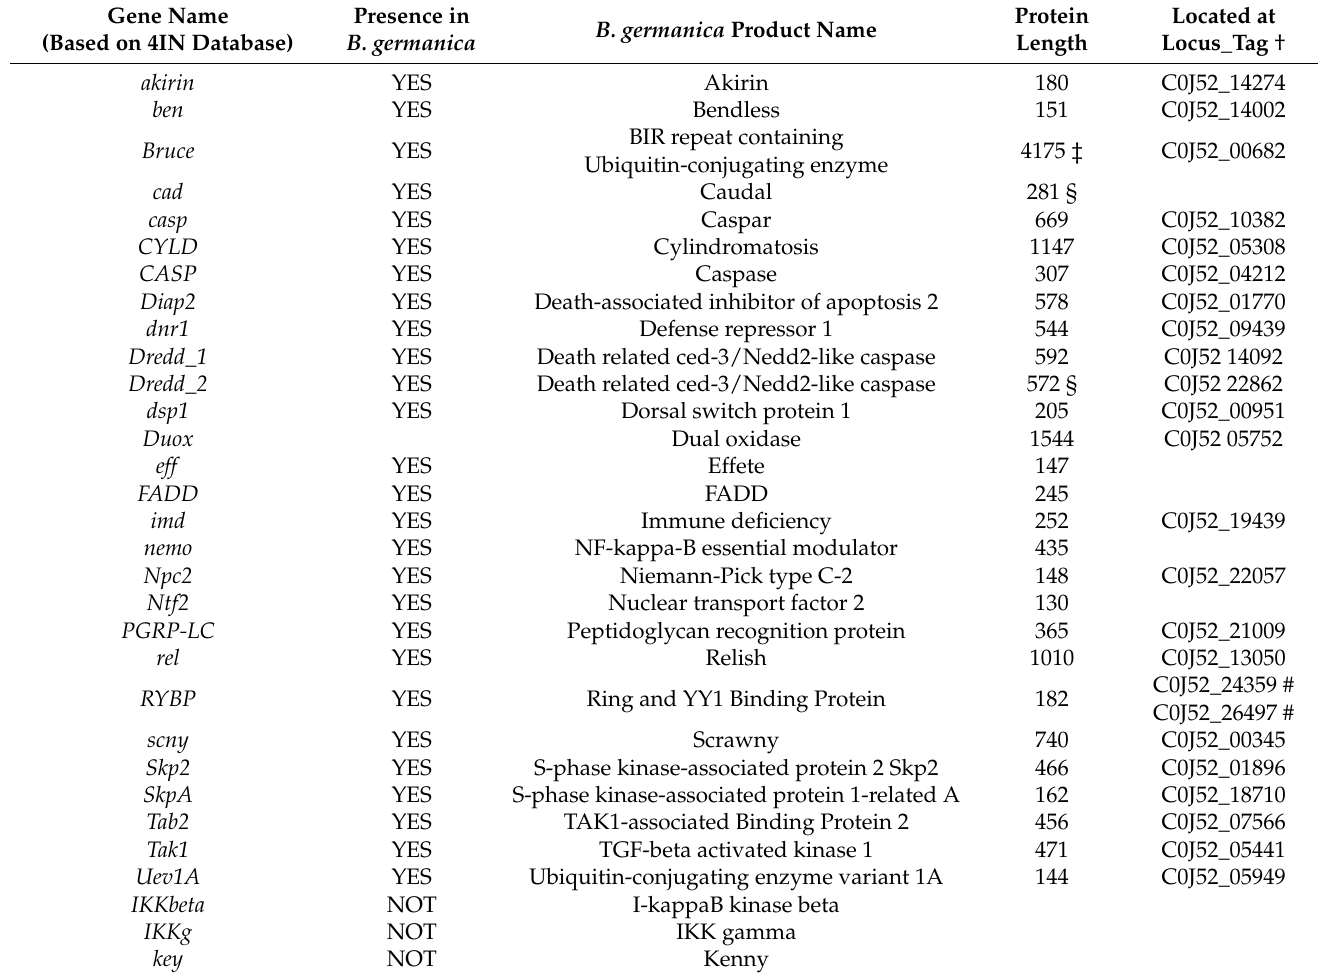
Table 1. Gene list of the IMD pathway in B. germanica based on transcriptomic